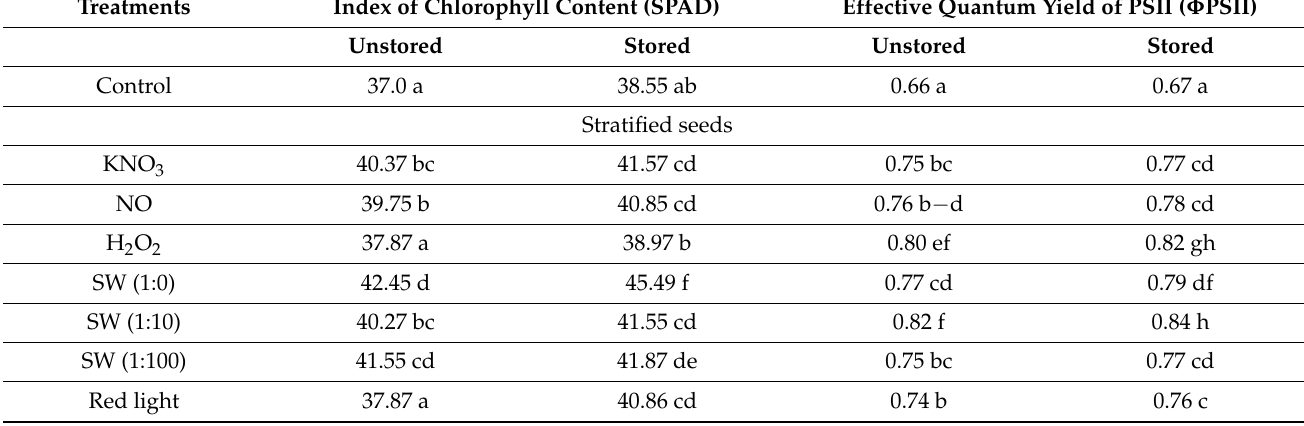
Table 3. Index of chlorophyll content (SPAD) and effective quantum yield of PSII ( Φ PSII) of Saskatoon berry seedlings derived from unstored and stored seeds subjected to (A) stratification (3 ◦ C) in the presence of KNO 3 , NO, H 2 O 2 , smoke-water (SW, in concentrations of 1:1, 1:10, 1:100), red light or 20 ◦ C/3 ◦ C or (B) scarification: sandpaper, sulfuric acid for 10, 20, 30 and 40 min, or treatments with pulsed radio frequency (PRF, 20/5/2/10, 60/25/4/10,